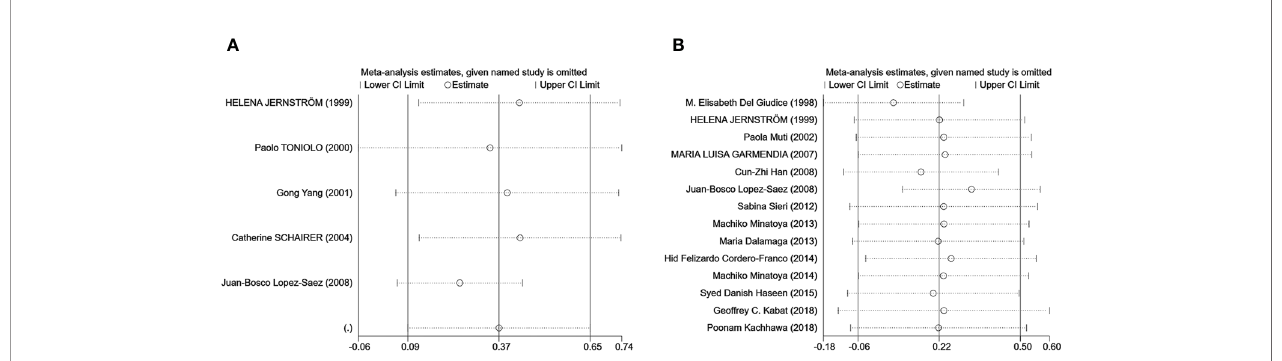
FIGURE 8 | The result of the sensitivity analysis on the association between C-peptide (A) or insulin (B) and breast cancer. Sensitivity analyses for the in fl uence of individual studies on the summary SMD. The vertical axis indicates the overall SMD, and the two vertical axes indicate its 95% CI. Every hollow round indicates the pooled SMD when the left study is omitted in this meta-analysis. The two ends of every broken line represent the respective